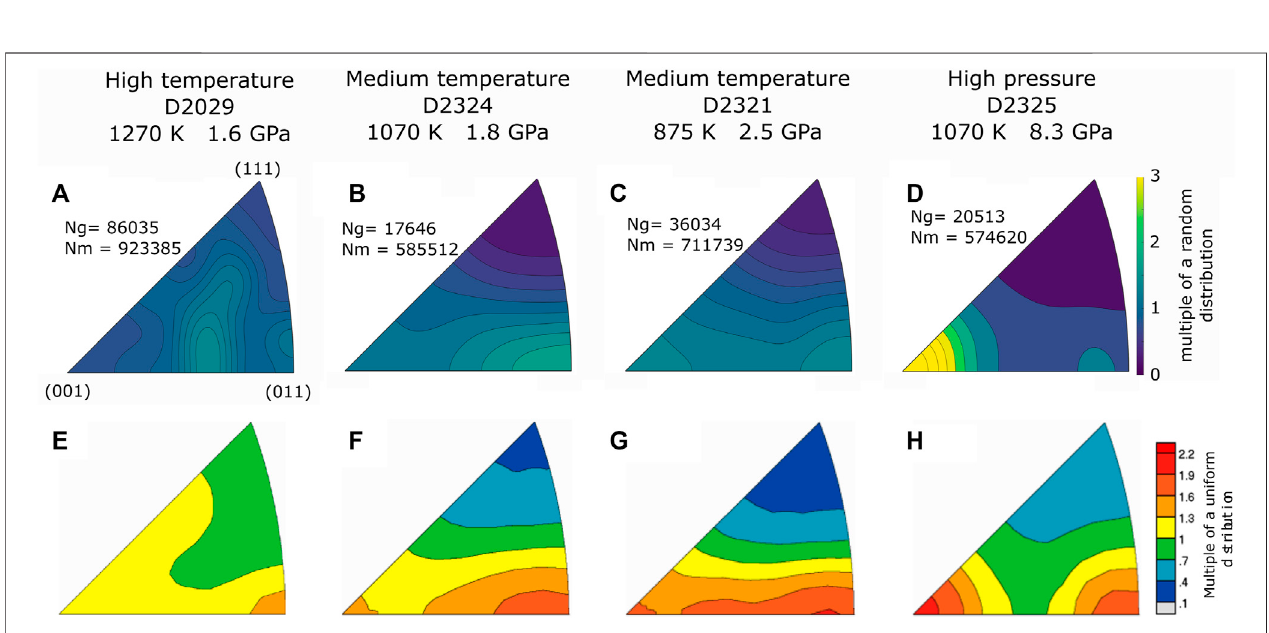
FIGURE 5 | Representative inverse pole fi gures (IPF) of the compression direction from SEM-EBSD (A – D) and in-situ XRD measurements at the maximum strain (E – H) . (A,E) : texture for sample deformed at high temperature (1,270 K). (B,C,F,G) : texture for samples deformed at moderate temperature (875 – 1,070 K). (D,H) : texture for the sample deformed at 8.3 GPa and 1,070 K. Ng is the number of grains in the EBSD map from which the orientation distribution was computed and Nm is the number of measure points used to compute the IPF. Note that these textures were extracted over a broader area than that shown in Figure 8 .